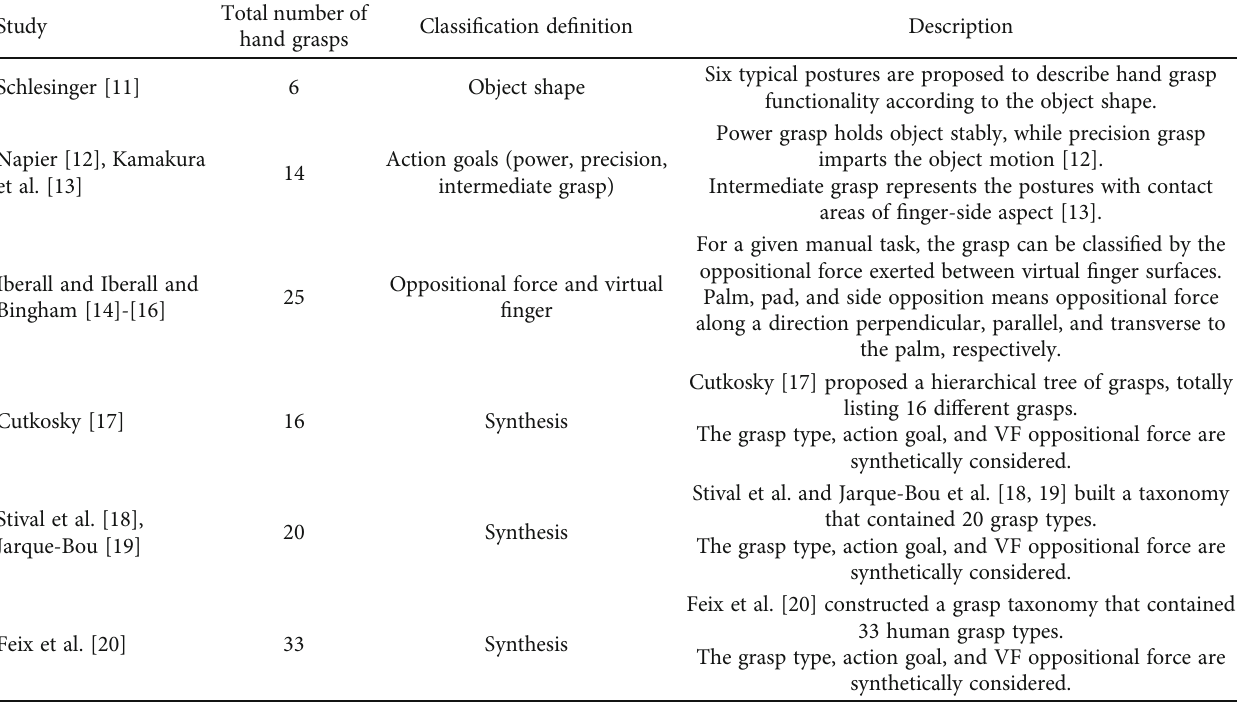
Table 1: Summary of selected precious studies on grasp classi fi cation for describing hand grasp functionality.